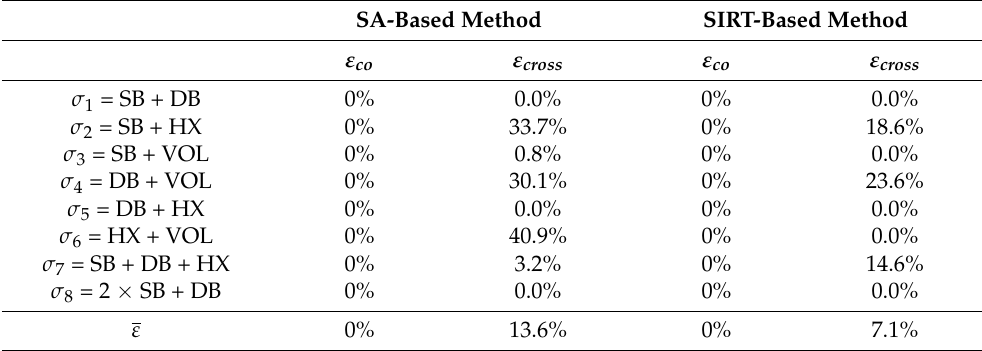
Table 7. Inaccuracies for SA- and SIRT-based decompositions revealed for linear combinations of polarimetric signatures. Recognized signatures are specified in percentage.